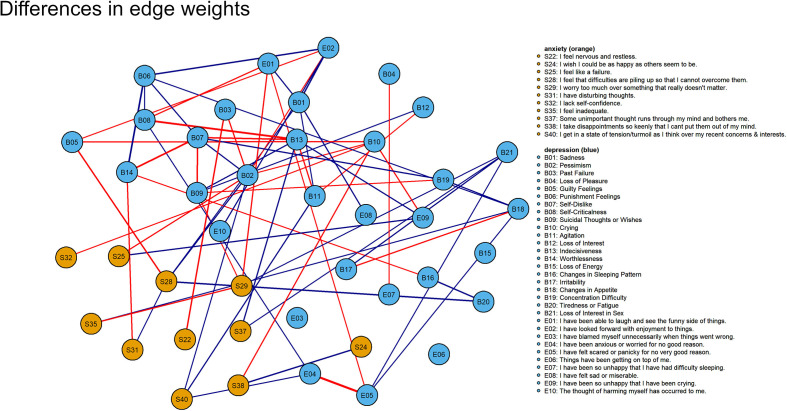
Network of differences in edge weights between the prenatal and post-partum depressive-anxiety networks. Blue edge denotes this edge was stronger in post-partum network than prenatal network. Red edge denotes this edge was stronger in the prenatal network. Weak differences with edge weight less than 0.05 are not shown here.